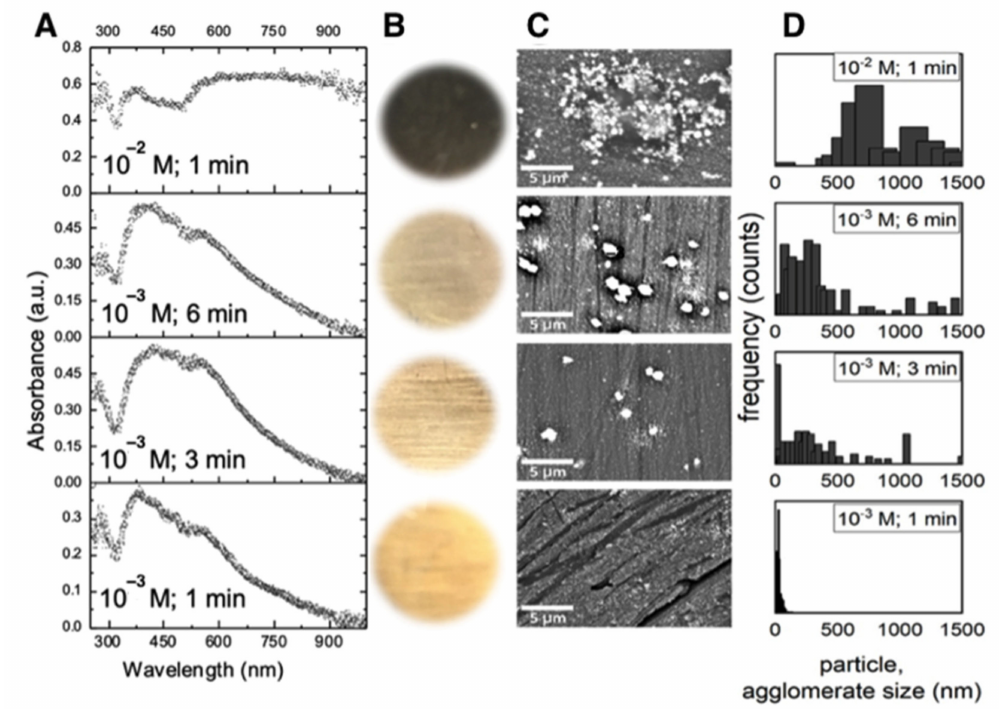
Figure 10. ELD of Ag-nanoparticles on Mg-Ca0.3 surface form 10 − 3 M and 10 − 2 M AgNO 3 solutions at different times: ( A ) UV-Vis absorption spectra (evolution over time), ( B ) representative circular images, ( C ) SEM micrographs of selected areas (5000 × ), and ( D ) Ag-NPs and agglomerate size distribution on the Mg-Ca0.3